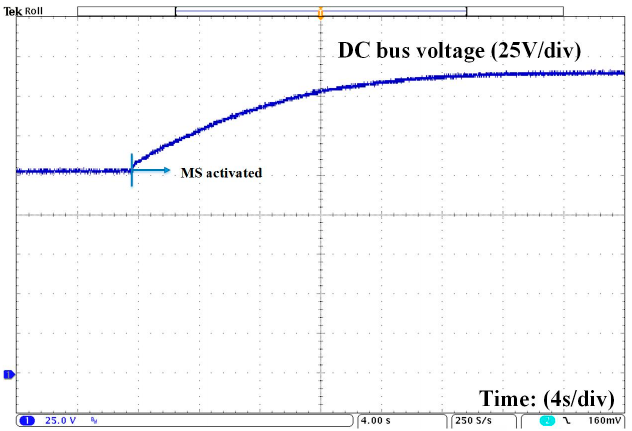
Figure 16. Bus behavior when the control and management system (CMS) is switched on.